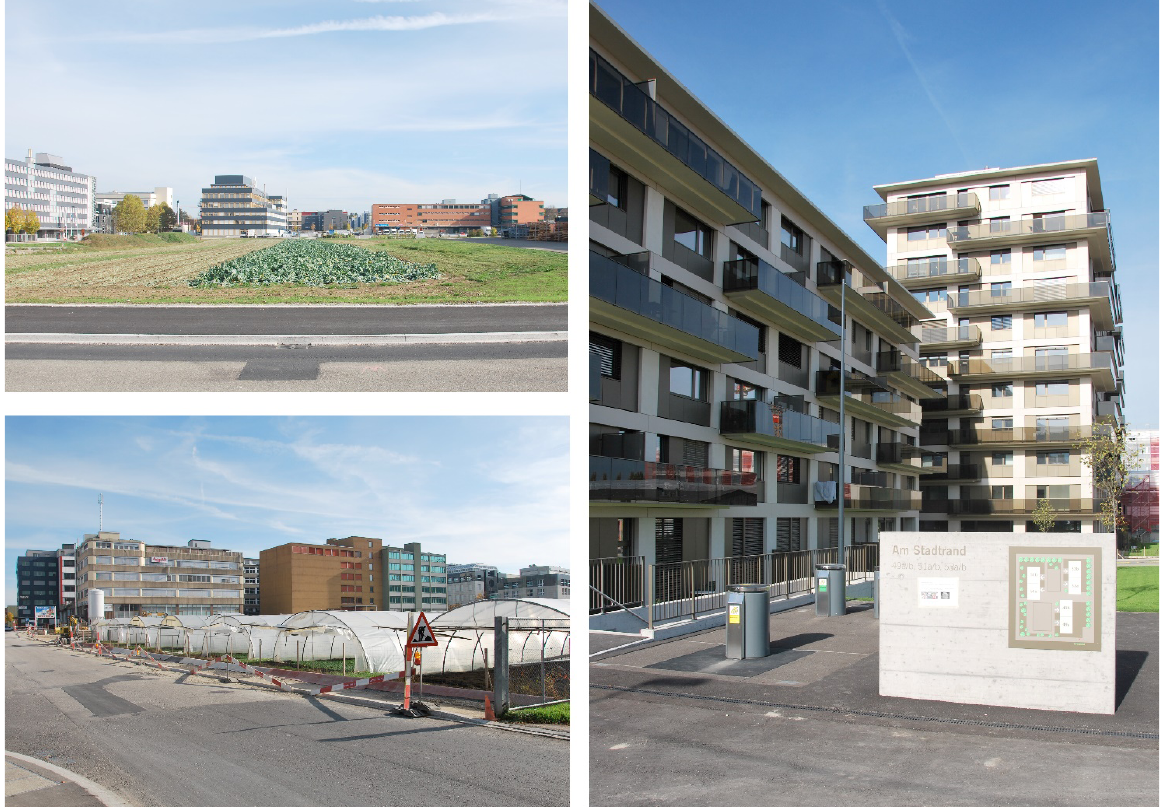
Figure 6. First building projects for the restructuring of the Hochbord area are already completed and represent high density housing projects. Source: